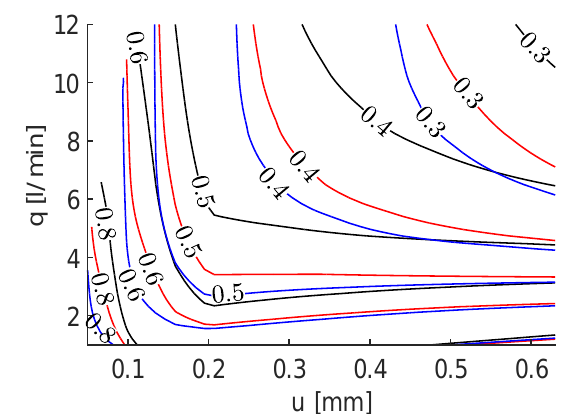
Figure 3: α AL (u,q) for HV at 20(black), 40(red), Figure 4: α AL (u,q) for HV(black) HEES(red)